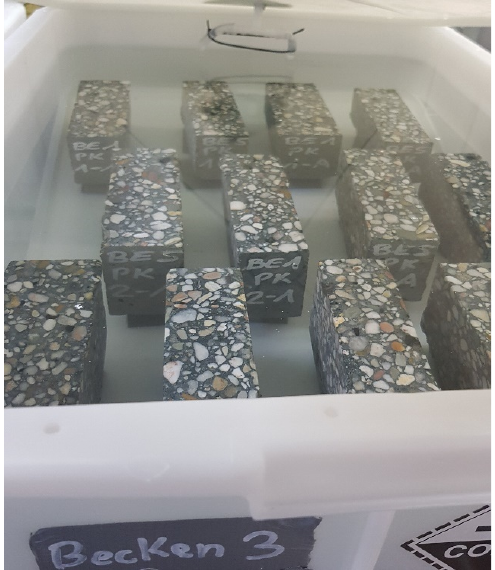
Figure 3. Concrete specimen in a storage tank with sulfuric